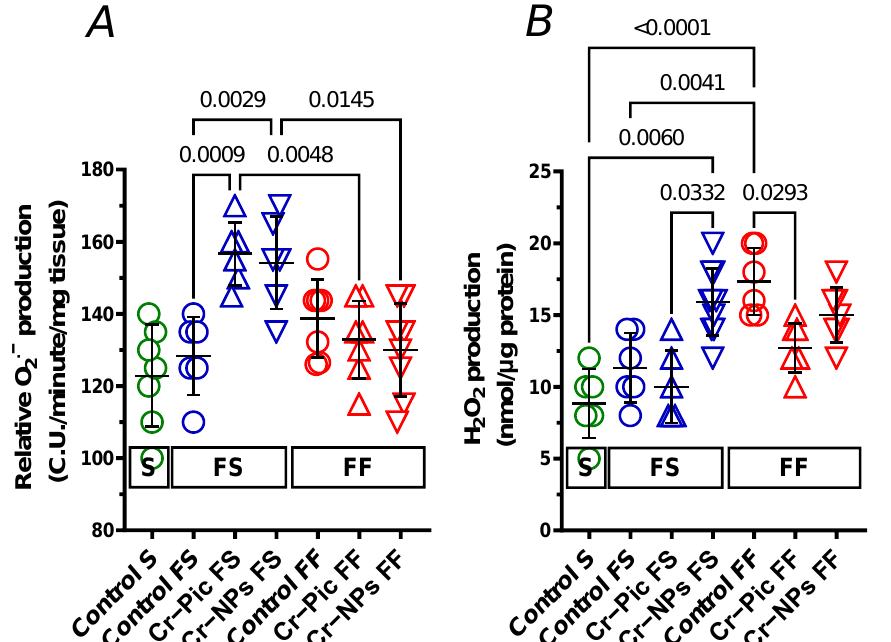
Figure 9. Production of superoxide anion ( A ) and hydrogen peroxide ( B ) in aortic rings from either chromium (Cr) supplemented (9 weeks of supplementation) or non-supplemented (Control) rats. 0.3 mg Cr/kg of body weight as chromium picolinate (Cr – Pic) and chromium nanoparticles (Cr – NPs) were added for 9 weeks of supplementation after the initial 9-week period of experimental feed without Cr supplementation. Two types of diet were applied: a standard-fat-and-fiber (S) diet and a high-fat – low-fiber (F) diet. Rats at 7 weeks of age were fed with an S diet or an F diet for either 9 weeks or 9 + 9 weeks. The following groups of rats were studied: Control S, the S diet plus the S diet; Control FS, the F diet and the S diet; Cr – Pic FS, the F diet and the Cr – Pic S diet; Cr – NPs FS, the F diet and the Cr – NPs S diet; Control FF, the F diet and the F diet; Cr – Pic FF, the F diet and the Cr – Pic F diet; Cr – NPs FF, the F diet and the Cr – NPs F diet. Values are means ± SD, n = 8, p ≤ 0.05 (two - way ANOVA/Tukey’s multiple comparisons test). In arteries from rats fed with the F diet for 9 weeks, both Cr – Pic and Cr – NPs increased relative O 2 . − production. In arteries from rats fed with the F diet for 18 weeks, Cr – Pic but not Cr – NPs decreased elevated H 2 O 2 production. 3.4.4. Detection of Hydrogen Peroxide In arteries from rats fed the F diet for 9 weeks, H 2 O 2 production did not change in the control FS group ( p = 0.5951). Neither Cr – Pic nor Cr – NPs modified that response. How- ever, a significant increase (1.59-fold) was observed in the Cr – NPs group vs. the Cr – Pic group (Figure 9B). In arteries from rats fed the F diet for 18 weeks, H 2 O 2 production increased in the control FF group (1.96-fold). Cr – Pic decreased (0.73-fold) the elevated H 2 O 2 production (Figure 9B). This was not observed for Cr – NPs (0.87-fold, p = 0.6087). 4. Discussion We examined the cardiovascular effects of a pharmacologically relevant dose of 0.3 mg Cr/kg body weight [10] in the form of picolinate (Cr – Pic) and metal nanoparticles (Cr – NPs) in male Wistar Han rats administered in 9- to 16-week-old rats together with imple- mentation of a high-fat – low-fiber (F) diet for either 9 or 18 weeks to investigate the role of dietary fat normalization. It is well-known that a prolonged high-fat diet intake results in the development of chronic systemic inflammation, as well as tissue and organ dysfunction, and our study confirmed this effect in rats fed the F diet for 18 weeks.